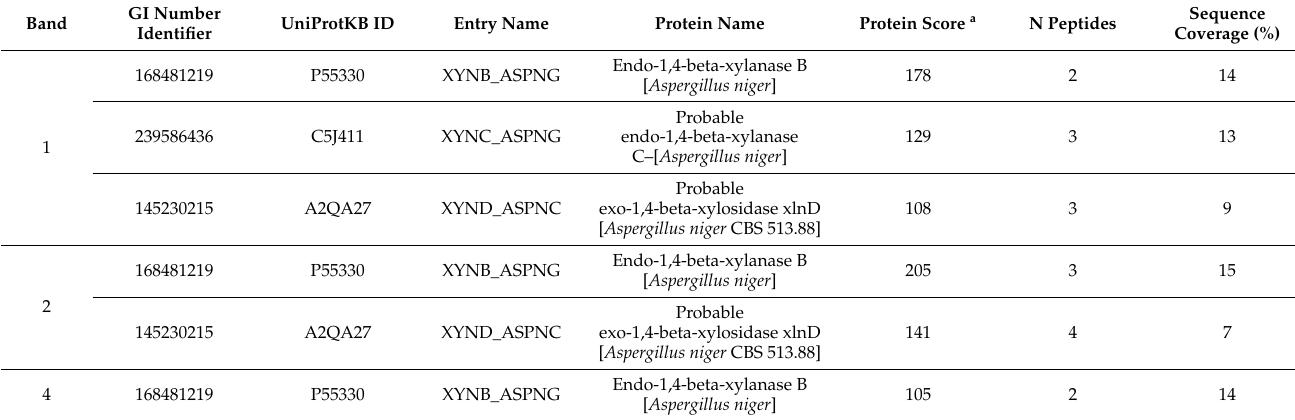
Table 4. Xylanase identified in the supernatant of Aspergillus niger LPB-334 strain. Bands were selected on the basis of zymograms as shown in Figure 7 and excised from the gel, in situ digested with trypsin and the resulting peptide mixtures were analyzed by LC-MS/MS. Band number corresponds to the band selected on the gel. Raw data were used to query the NCBI database with the taxonomic restriction to fungi as described in detail in the Materials and Methods section. Only proteins identified with two or more peptides were considered as confidently identified. Only proteins that have been annotated in the database as being involved in the metabolism of xylan have been reported.